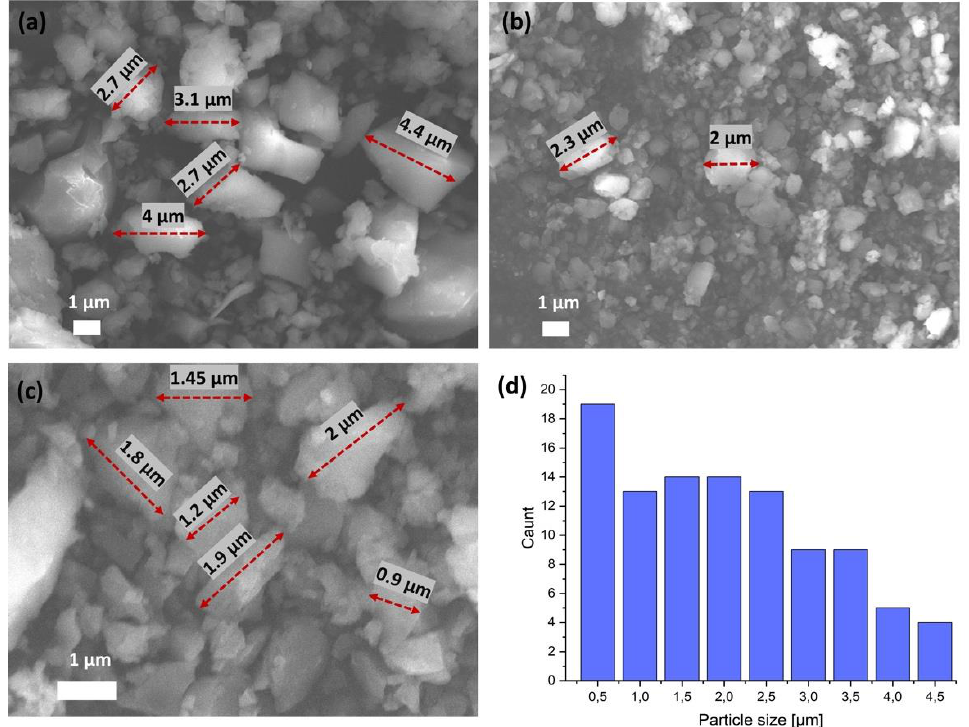
Figure 4. ( a – c ) SEM images and ( d ) average size distribution of oxovanadium(IV) microclusters with 2-phenylpyridine.